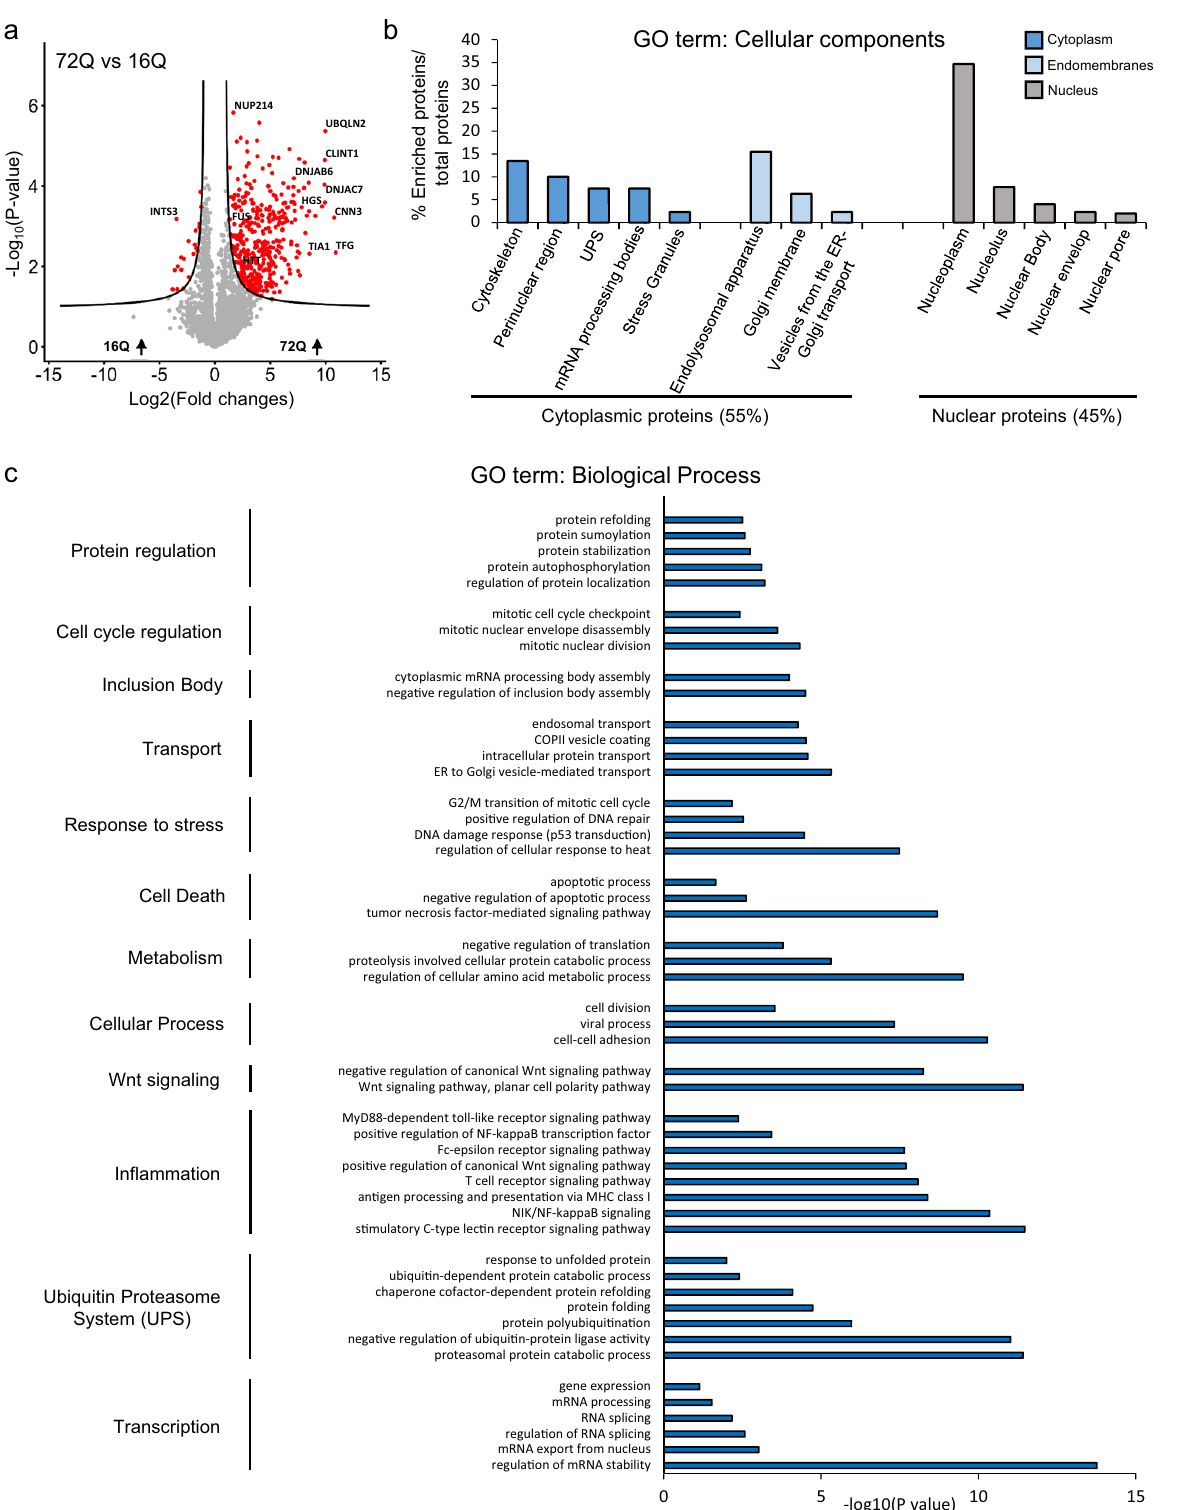
processinggene splicingmRNA splicingRNA nucleusregula(cid:2)on of RNA stabilitymRNA export from regula(cid:2)on of mRNA Fig. 3 Proteomic analysis of the enriched protein contents found in the insoluble fraction of HEK expressing Httex1 72Q reveals protein aggregation and stress response pathways. Urea soluble proteins from HEK expressing Httex1 72Q or Httex1 16Q of 3 independent experiments were extracted 48 h after transfection and analyzed using LC-MS/MS. a Identi fi ed proteins were plotted using a volcano plot. Black lines represent the threshold of signi fi cance at a false discovery rate (FDR) < 0.05 and an S0 of 0.5 which were used for the subsequent analysis. b , c Proteins signi fi cantly enriched in Httex1 72Q (red dots in the right part of the volcano plot) were classi fi ed by cellular component ( b ) or biological processes ( c ) using Gene Ontology (GO) term and DAVID enrichment ( − log 10 ( p -value) > 1) analyses. Source data are provided as a Source Data fi